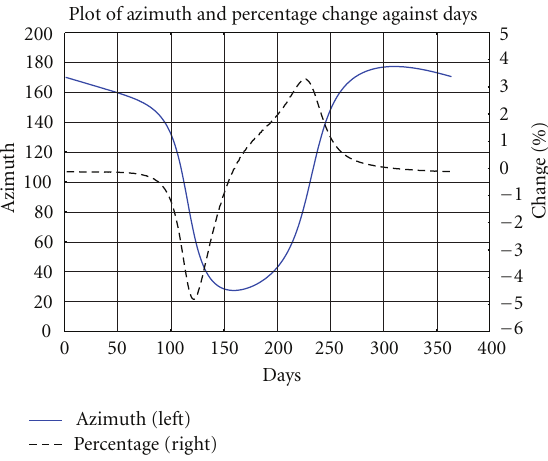
Figure 1: Plot of azimuth and percentage change against days of the year for Chom Bueng, Thailand (13.37N, 99.35E, altitude 86 m). Sharp peaks in the percentage change represent winter and summer solstice. The percentage change is simply the rate of increase or decrease of the azimuth from one day to the next, then multiplied by